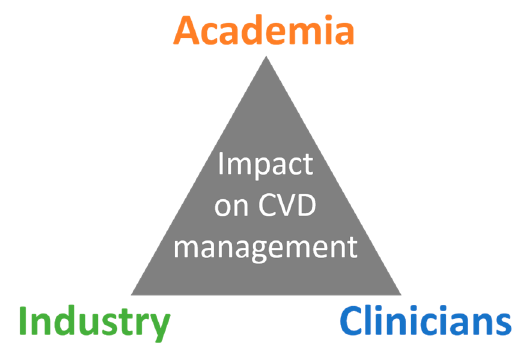
Figure 2. Di ff erent backgrounds of the network members and their interactions to impact cardiovascular Figure 2. Different backgrounds of the network members and their interactions to impact diseases (CVD) management, thus cardiovascular diseases (CVD) management, thus healthcare.